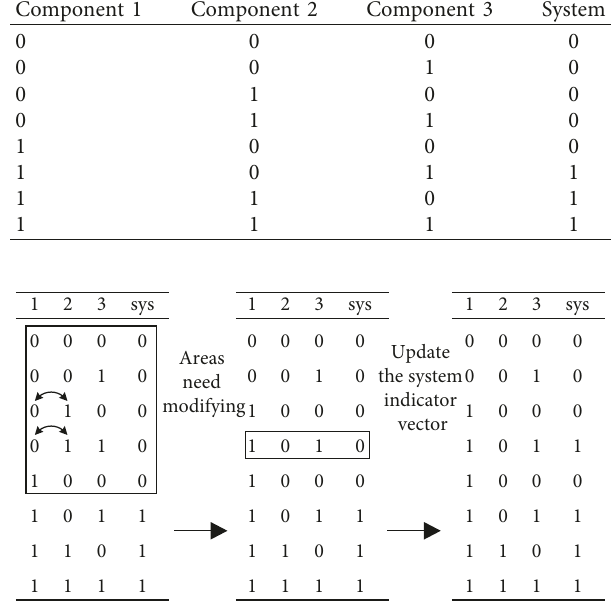
Figure 1: Schematic illustration of component swapping. (a) Before the swapping. (b) After the swapping. Table 1: Reliability truth table of the system with 3 components. Table 2: Survival signature of the system with and without